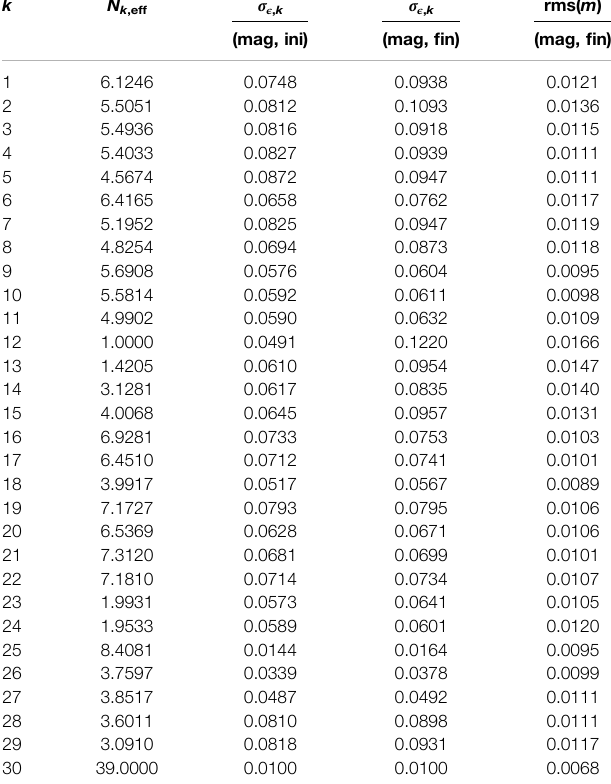
TABLE 6 | Lightcurve characteristics for the GS-asteroid in the case of relative photometry. First, we give the lightcurve identi fi er ( k ), effective number of observations ( N k ,eff , Eq. 20 ), and the resulting initial uncertainties ( σ ϵ , k , “ ini ” ). Second, we give the fi nal uncertainties ( σ ϵ , k , “ fi n ” ) and rms-values (rms( m ), “ fi n ” ) for the best- fi t model from convex inversion.